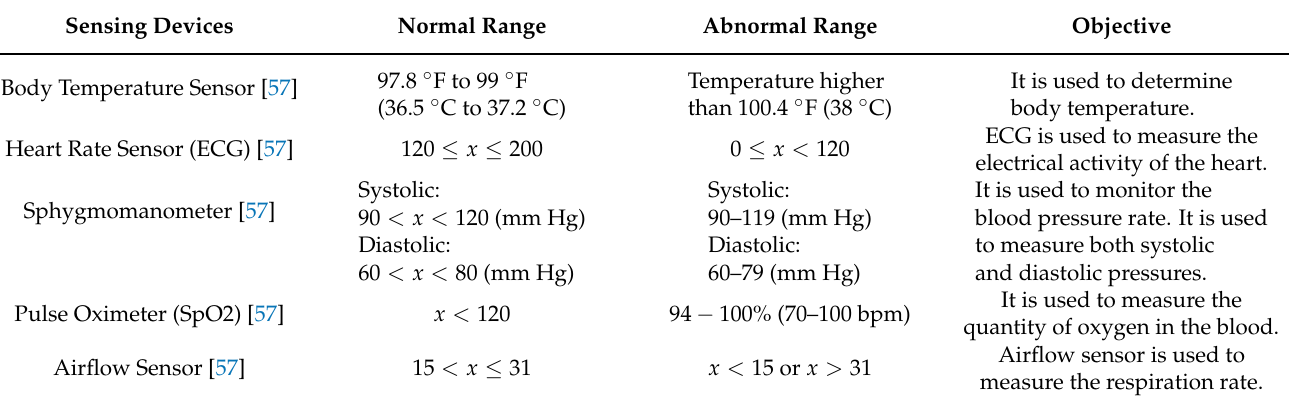
Table 6. Threshold for reading vital signs